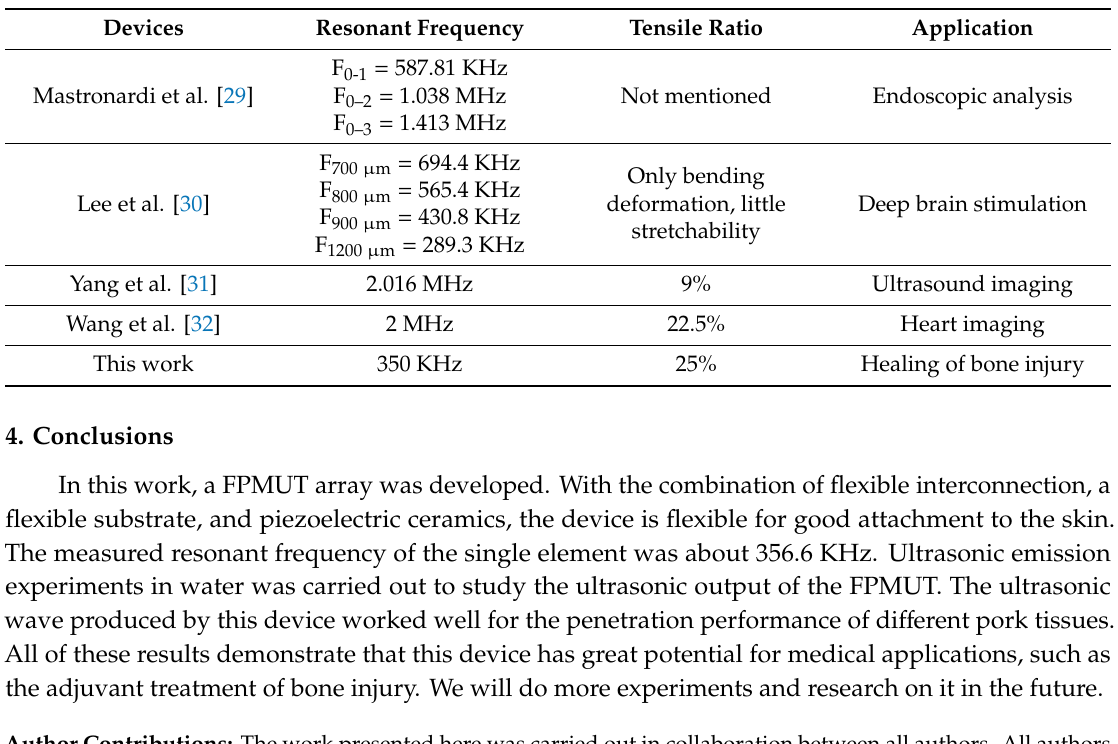
Table 4. Comparison of this work with previous